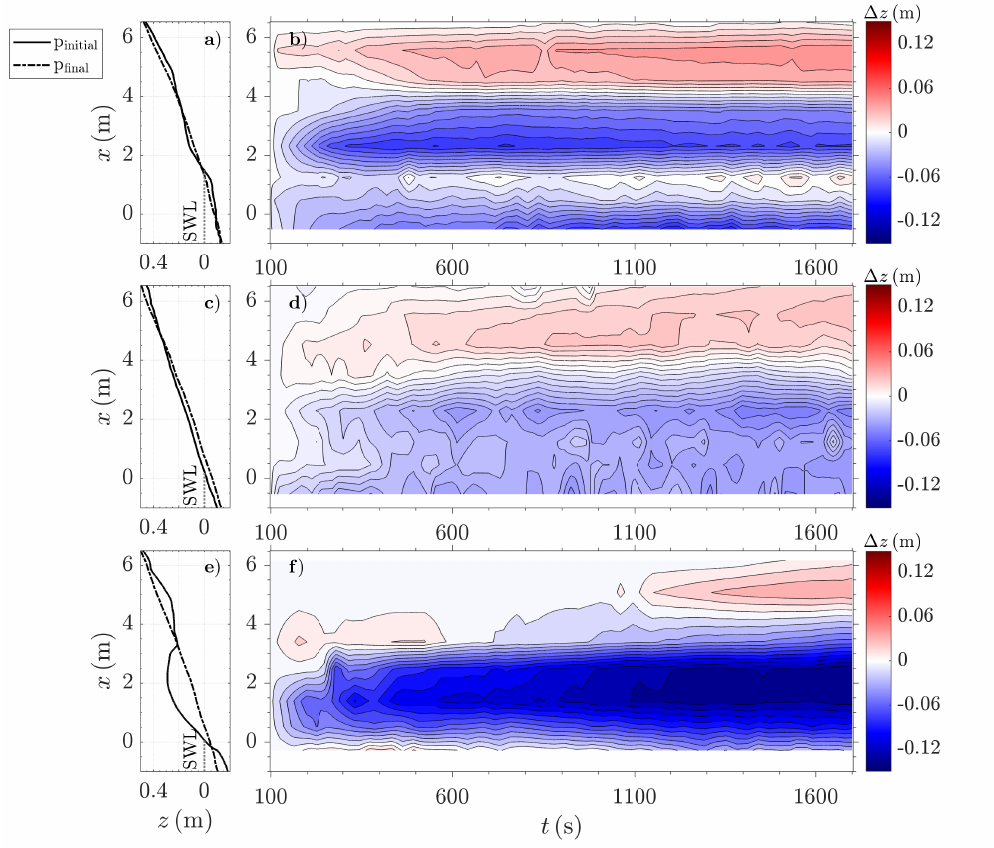
Figure 9. Profile evolution in the inner surf and swash zone within the first 30 min run (between 100s and 1700s): top, middle, and bottom panels correspond to case1, case 2 and case3, respectively. ( a,c,e ) Profiles measured by mechanical profiler before (p initial ) and after (p final ) the first run of condition E2; ( b,d,f ) Profile change ∆ z obtained from AWG